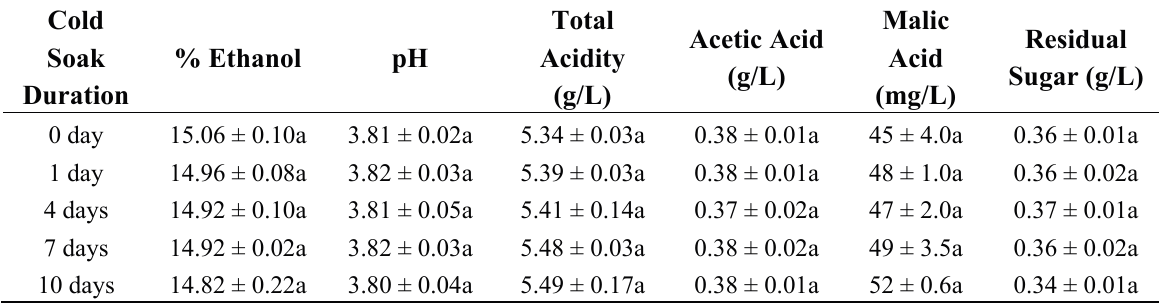
Table 1. Chemical composition of finished wines made with different CS